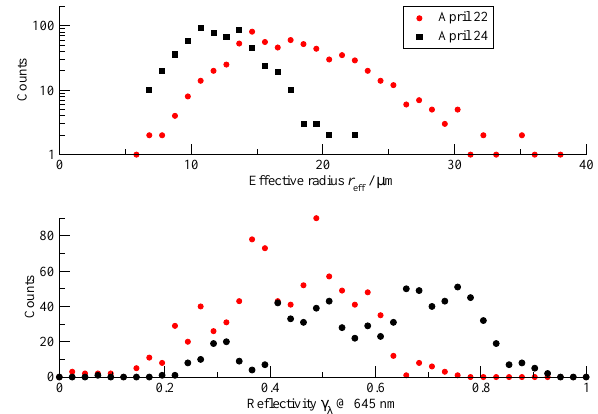
Fig. 15. Frequency distributions of the effective radius r eff (up- per panel) and reflectivity (lower panel) at 645nm measured with